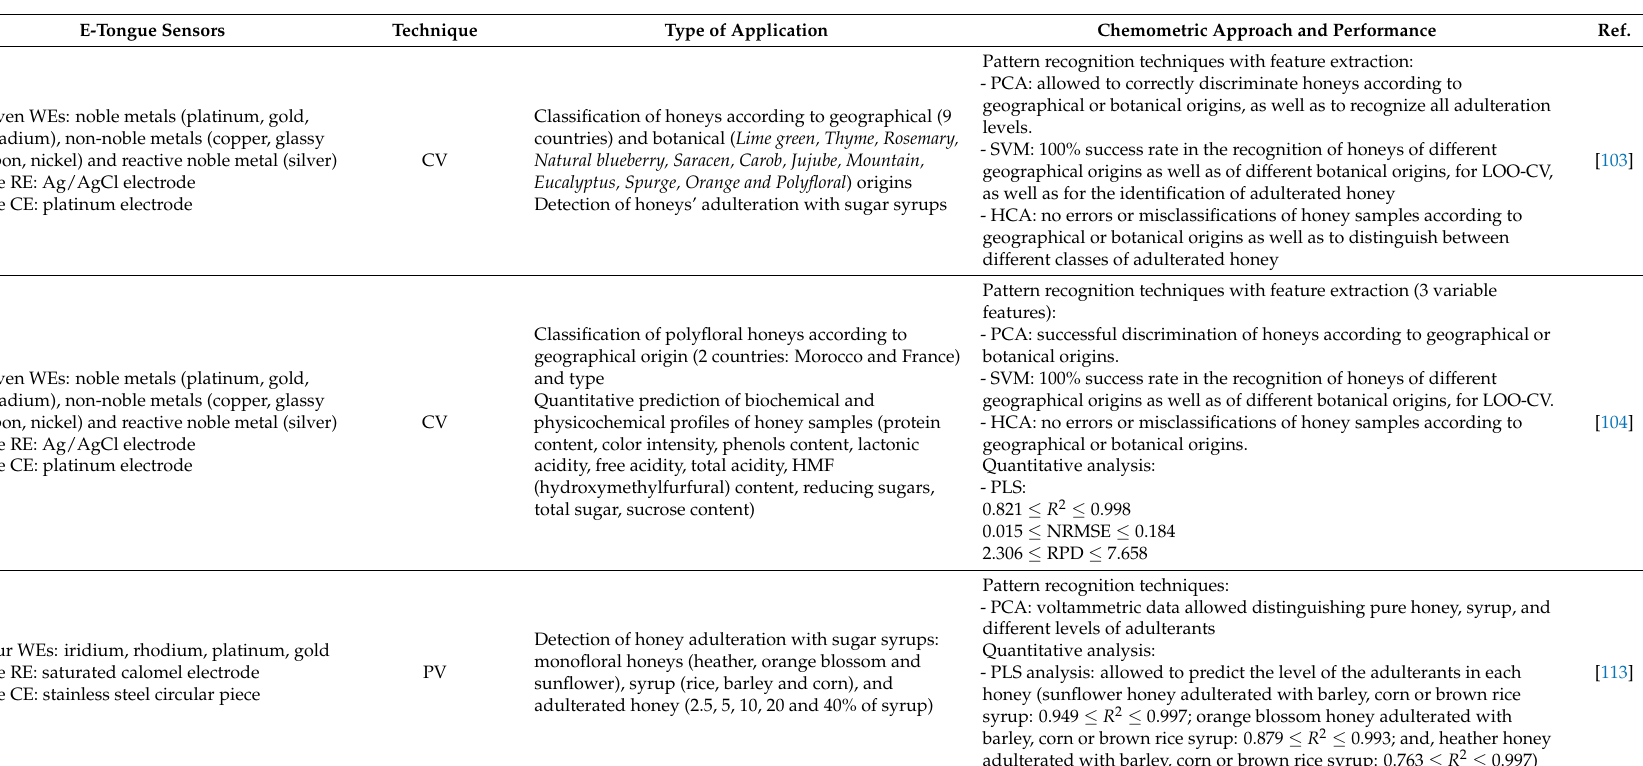
Detection of honey adulteration with sugar syrups: monofloral honeys (heather, orange blossom and sunflower), syrup (rice, barley and corn), and adulterated honey (2.5, 5, 10, 20 and 40% of syrup)